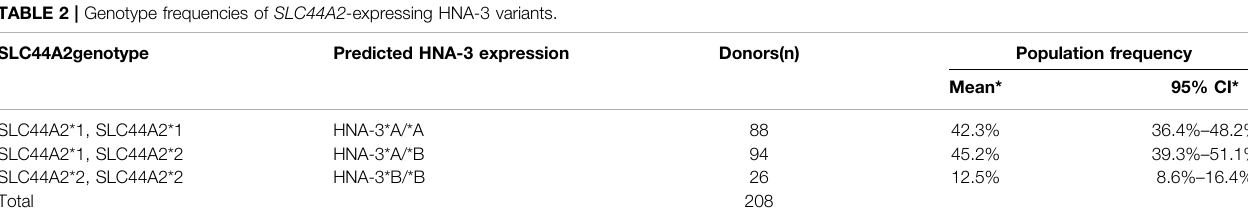
TABLE 2 | Genotype frequencies of SLC44A2- expressing HNA-3 variants.